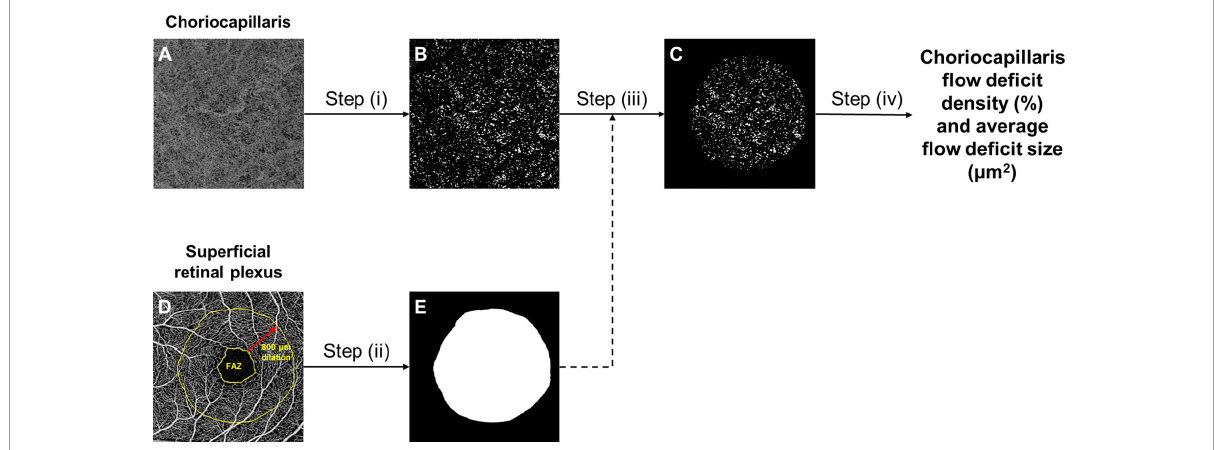
FIGURE1 The framework of choriocapillaris OCTA image processing. Raw choriocapillaris OCTA image extracted from the OCTA machine (A) was binarized with a threshold of 1.5 standard deviation below the mean intensity of the image to segment flow deficits (B) . Foveal avascular zone (FAZ) segmented from the raw superficial retinal plexus OCTA image was dilated by 800 µ m (D) to generate a mask (E) that indicates the region to be analysed. The mask (E) was applied to the segmented flow deficits (B) to generate the final flow deficit image (C) where the density and size of flow deficits were